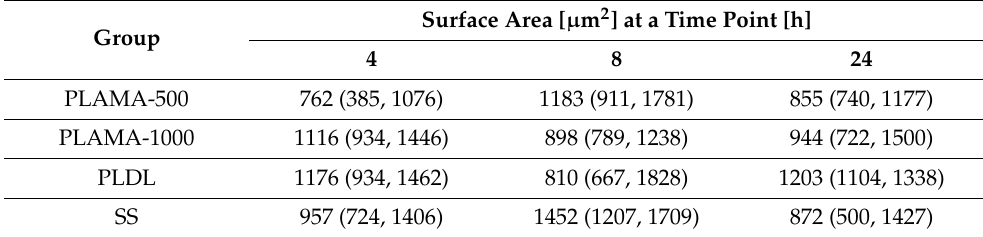
Table 9. Numerical results of the cell morphology test: surface area of cells.